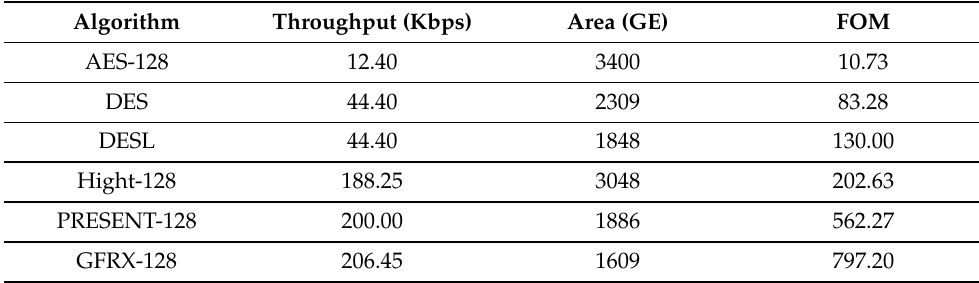
Table 5. Performance comparison of common lightweight block